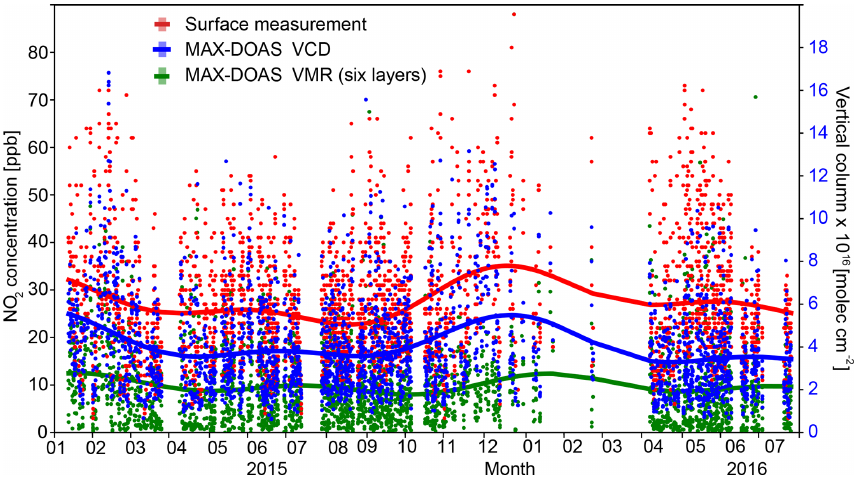
Figure 7. Hourly NO 2 averages of in situ surface concentrations (red) in parts per billion, total VCDs from the MAX-DOAS instrument (blue) in molecules per cubic centimeter and the average VMR of the first six layers (up to 550m) in the retrieved MAX-DOAS profiles (green), also in parts per